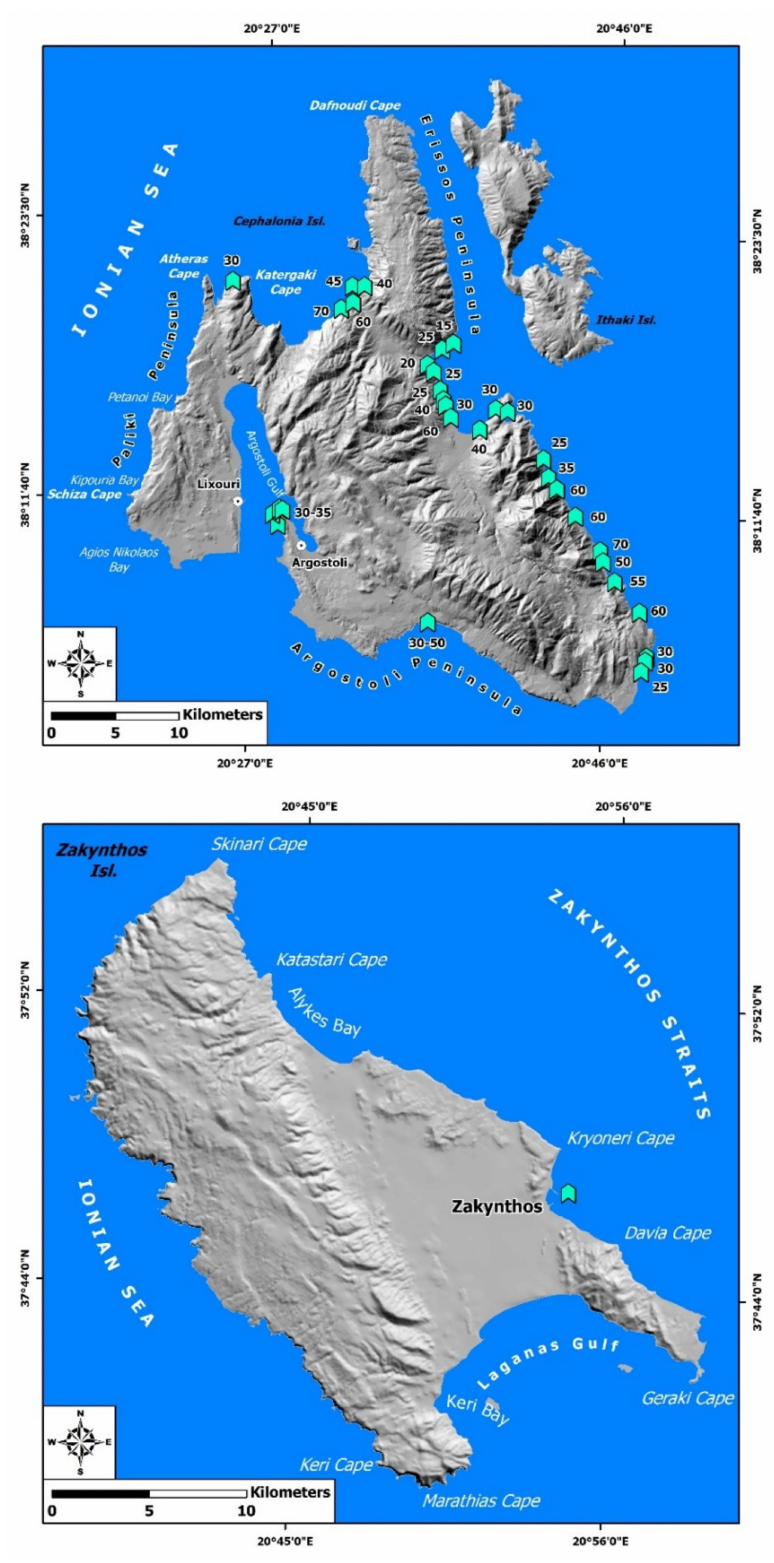
Figure 5. Sites in Cephalonia and Zakynthos uplifted by the August 1953 earthquakes with the amount of uplift in cm in each site, based on studies conducted by Galanopoulos [18], Mueller- Miny [19], Stiros et al. [21] and Pirazolli et al.